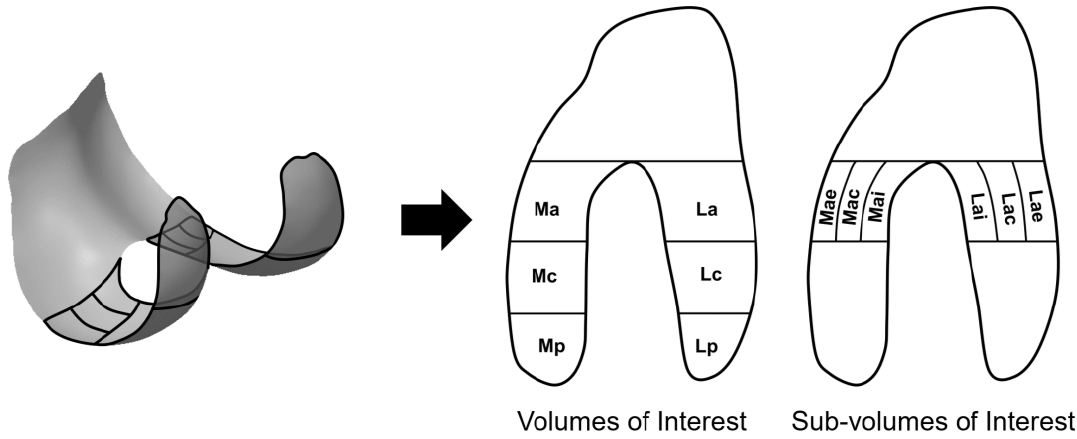
Figure 2. Cartilage volumes of interest (VOIs) and sub-VOIs displayed on a representative femur.